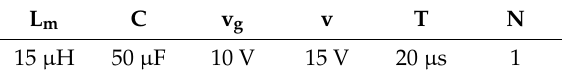
Table 1. Specifications of the Tested Flyback Converter.